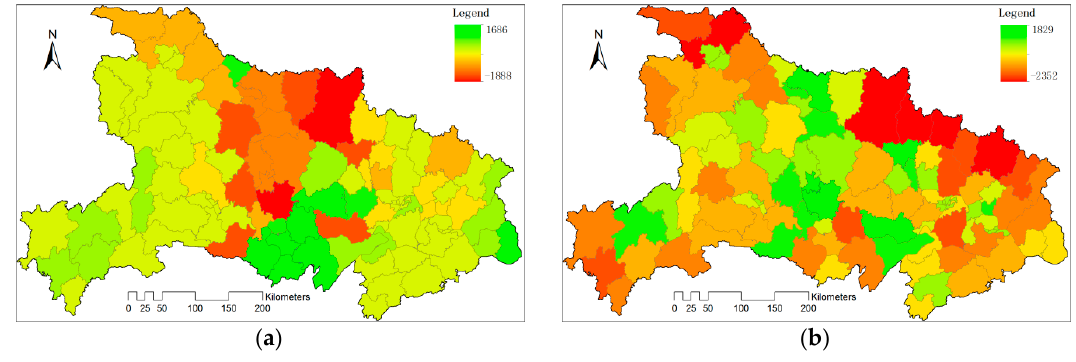
Figure 10. Sen trend maps of the cropping frequency at county level, ( a ) DC and ( b ) SC.